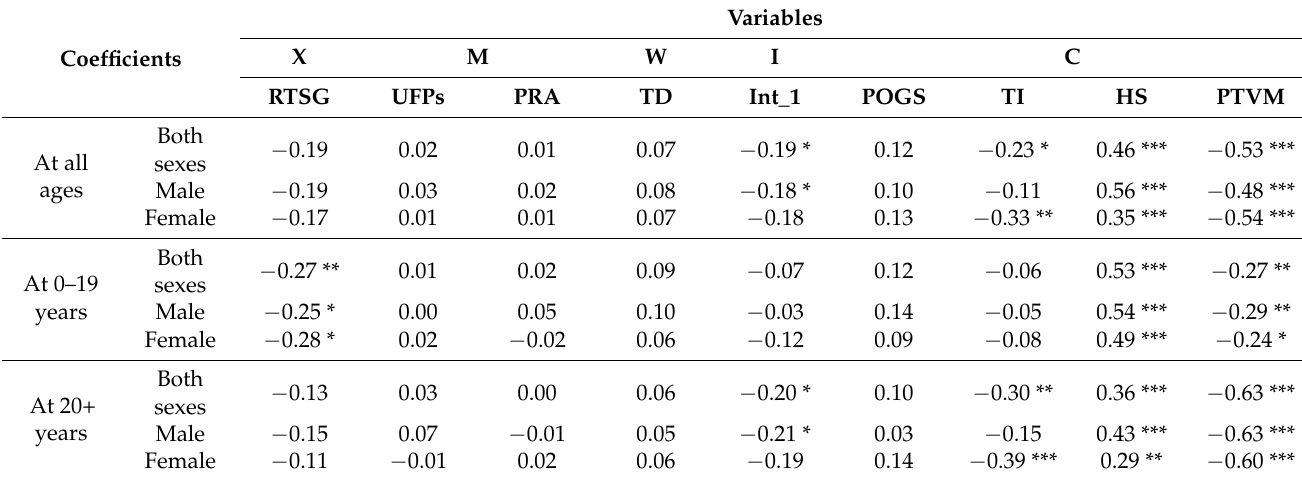
Table 4. Coefficients of variables (outcome variable: Prevalence of